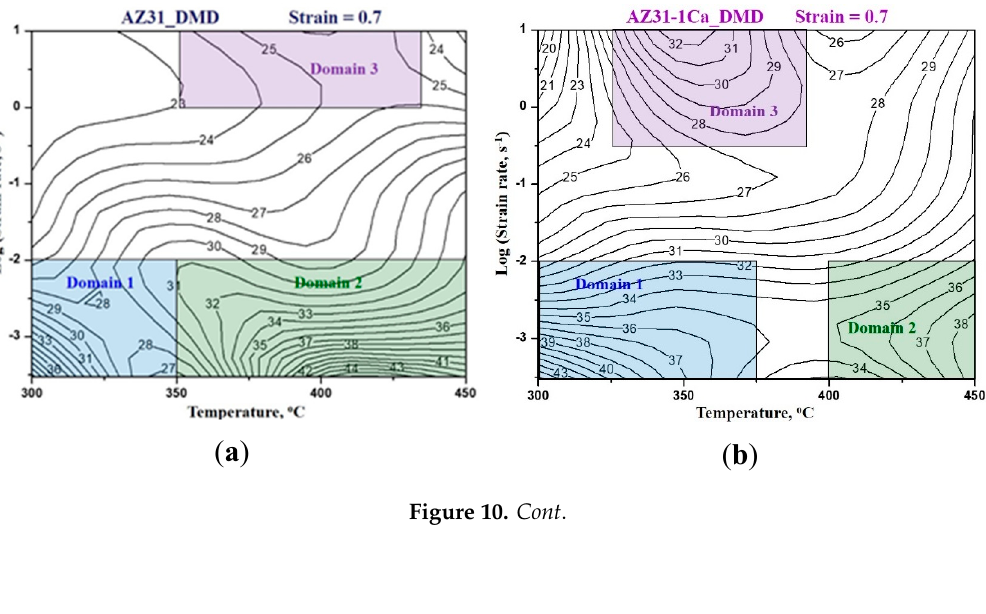
Figure 9. Microstructures obtained on DMD processed AZ31-3Ca alloy specimens deformed at ( a ) 400